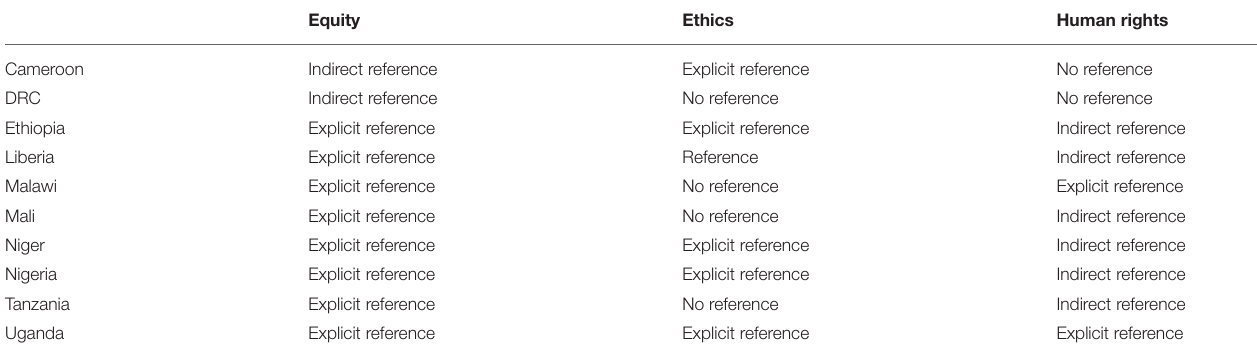
TABLE 6 | References to equity, ethics, and human rights within digital health